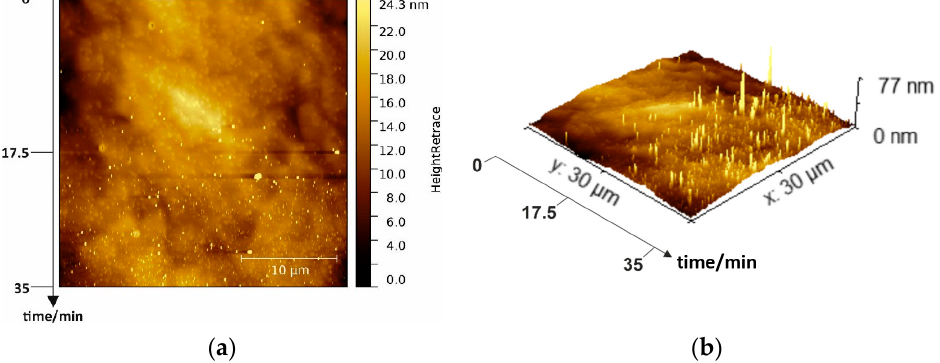
Figure 3. ( a ) A 30 × 30 µm² overview 2D AFM image of wet chemically cleaned p-GaN and ( b ) corresponding 3D image.